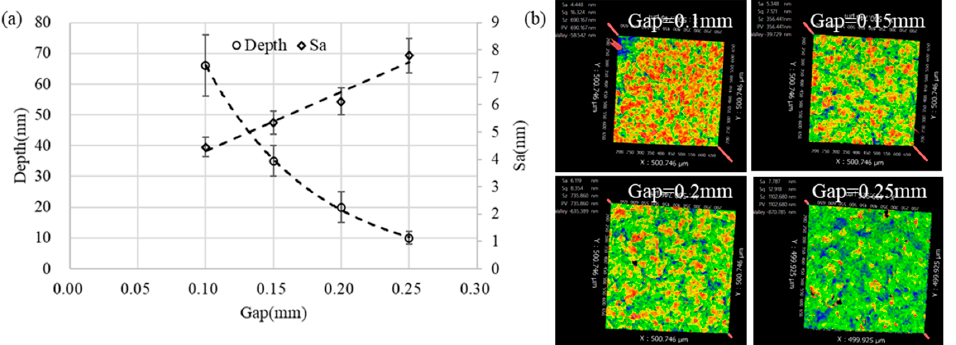
Figure 12. The influence of the gap on the removal pit: ( a ) the depth and the bottom surface roughness and ( b ) the bottom surface morphology (time = 300 s, amplitude = 40 μ m).